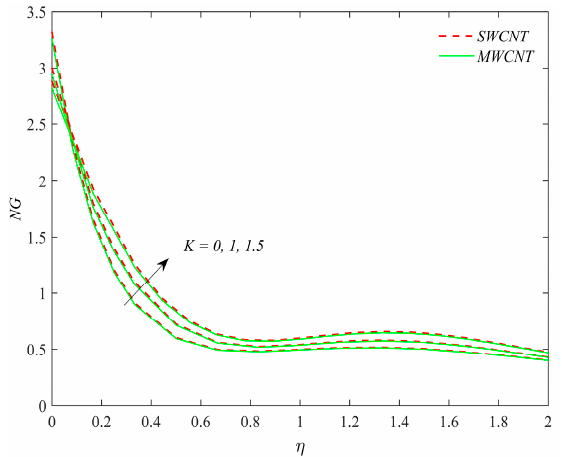
the similarity variable for the distinct values of the Reynold number Ra x .